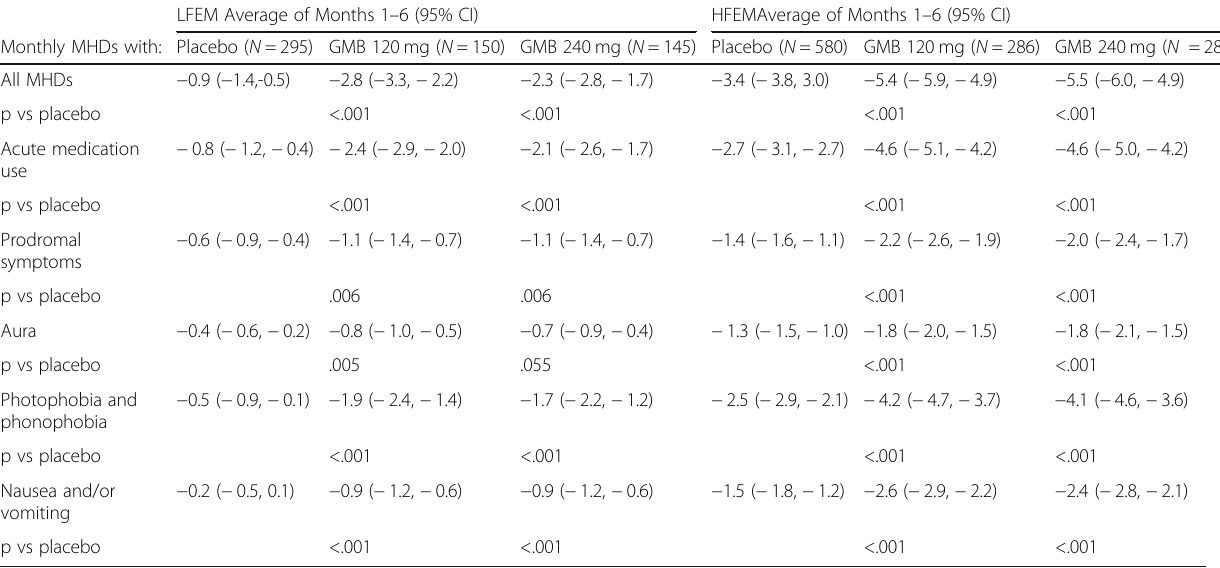
Table 2 Reduction over Months 1 to 6 in mean monthly MHDs with associated